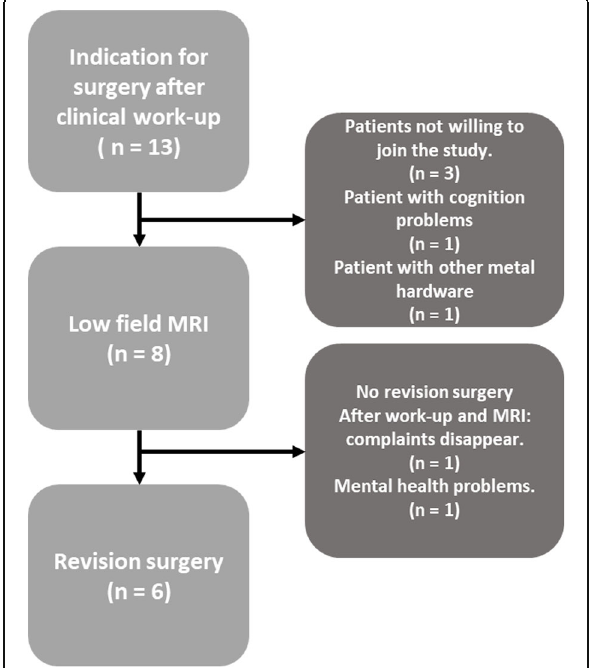
Fig. 1 Patients selection